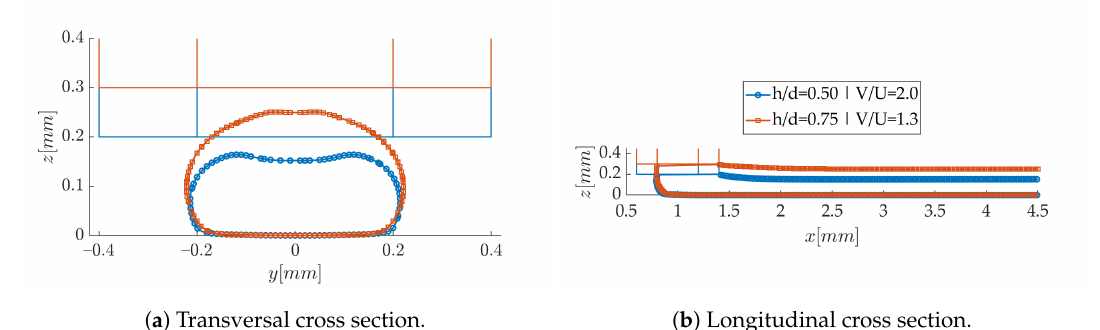
Figure 16. Effect of nozzle separation on the strand shape.